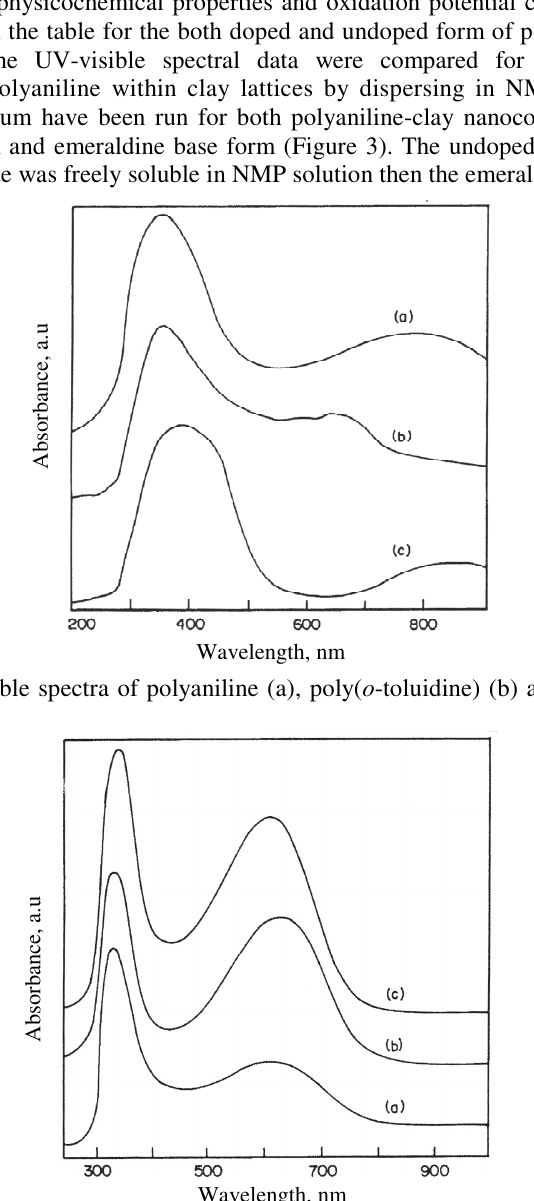
Figure 3. UV-visible spectra of polyaniline (a), poly( o -toluidine) (b), and poly( o -anisidine) (c) dedoped with dilute